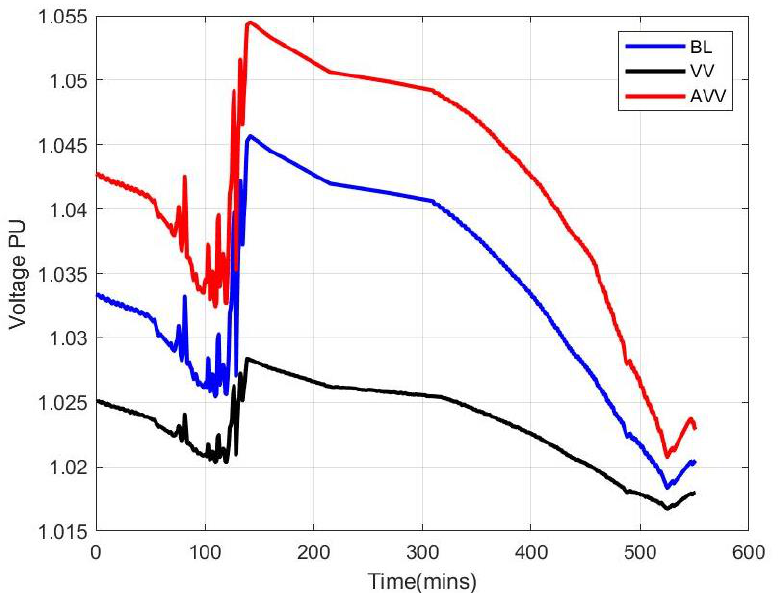
Figure 6. Voltage Per Unit across IEEE 13-bus Test Feeder for Baseline, Volt-Var controlled, and Attacked Volt-Var